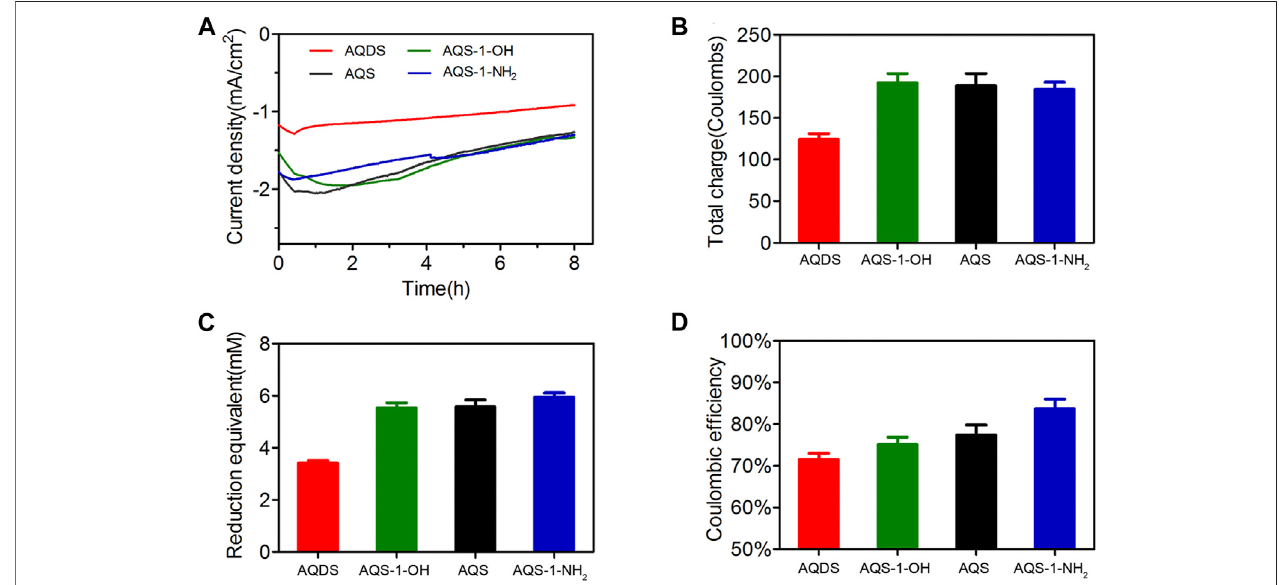
FIGURE 3 | The electrochemical behaviors ofAQS and derivatives in MES. (A) Current density produced bya cathode in the presence ofdifferent AQS derivatives under the potential of − 0.65 V (vs. Ag/AgCl). (B) Total charge production produced by a cathode after 8-h electrosynthesis period. (C) Reduction product equivalent (succinate production) produced in MES after 8-h electrosynthesis period. (D) Coulombic ef fi ciency of MES in the presence of different AQS derivatives. Results are representative of at least two independent experiments performed in triplicate and are expressed as mean ± standard deviation (SD).